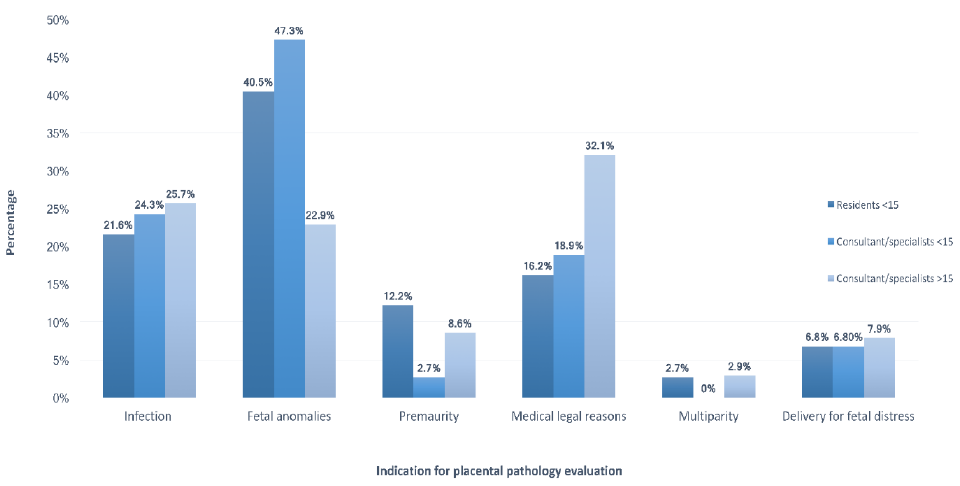
Figure 2. Indications for pathological examination of placentas in relation to different levels of the participants’ training and experience when the CAP guidelines were not used.